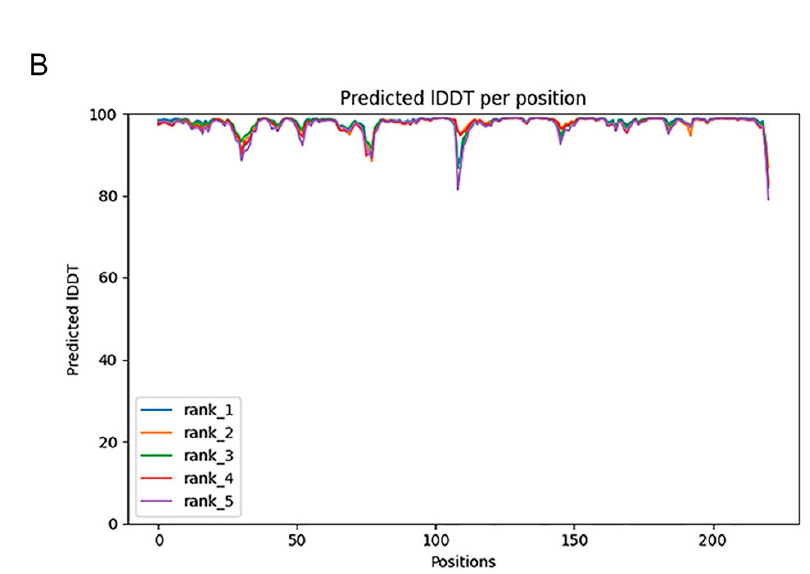
Figure 1. ( A ) 3D structure of chitosanase Q875I9 predicted by Alphafold2 (cyan represents the helix, yellow represents the sheet, gray represents the loop). ( B ) The predicted lDDT of five predicted structures given by Alphafold2.